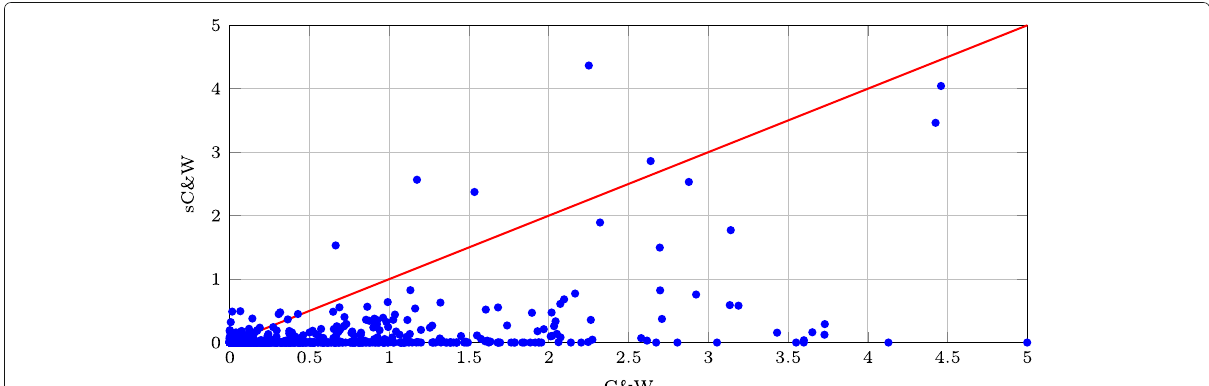
Fig. 4 MAD scores [35] of sC&W vs. C&W for all images of ImageNet. For 93% of the images below the diagonal, sC&W is less perceptible than C&W according to MAD score